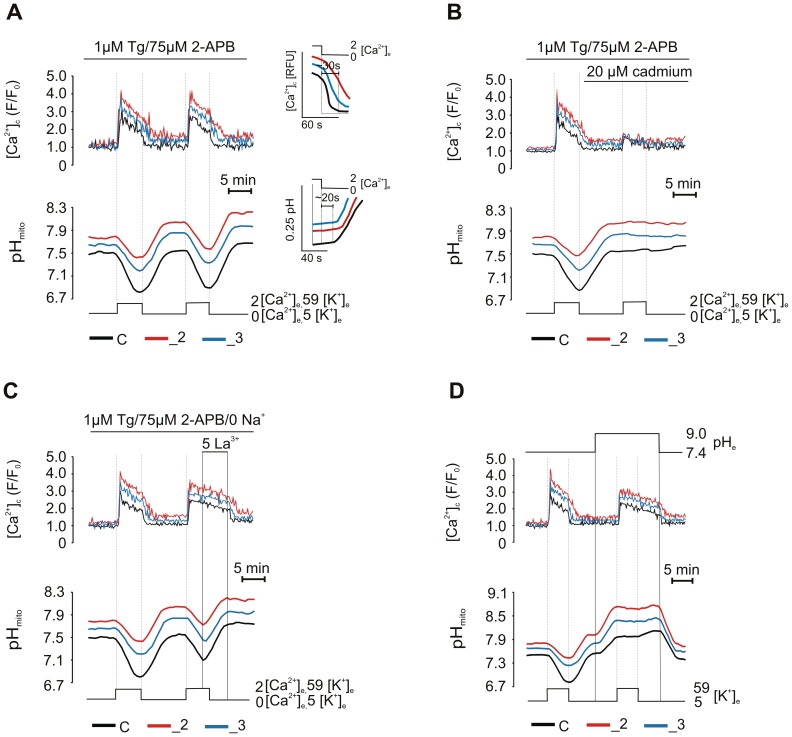
The response of mitochondrial pH to the inhibition of an efflux and the release component of (Ca2+)c elevations.(A) The average effect of extracellular Ca2+ removal and its subsequent restitution on (Ca2+)c and pHmito changes in n = 18, n = 12, n = 21 cells for C, _2, _3 lines respectively, pretreated for 20 min with thapsigargin and 2-APB. The insets show SERCA-independent (Ca2+)c clearance (upper) and pHmito recovery (lower). (B) The average effect of cadmium (VDCCs inhibitor) in n = 29, n = 19, n = 22 cells for C, _2, _3 lines respectively, on KCl-evoked (Ca2+)c influx and concomitant pHmito changes. (C) The average effect of 5 mM La3+ in n = 16 cells for C, _2, _3 lines showing delay in (Ca2+)c clearance and pHmito alkalization under low extracellular Na+. (D) The average effect of extracellular alkaline pH (9.0) followed by pH return to 7.4 in n = 20, n = 12, n = 20 cells for C, _2, _3 lines respectively, on (Ca2+)c elevations and pHmito changes.